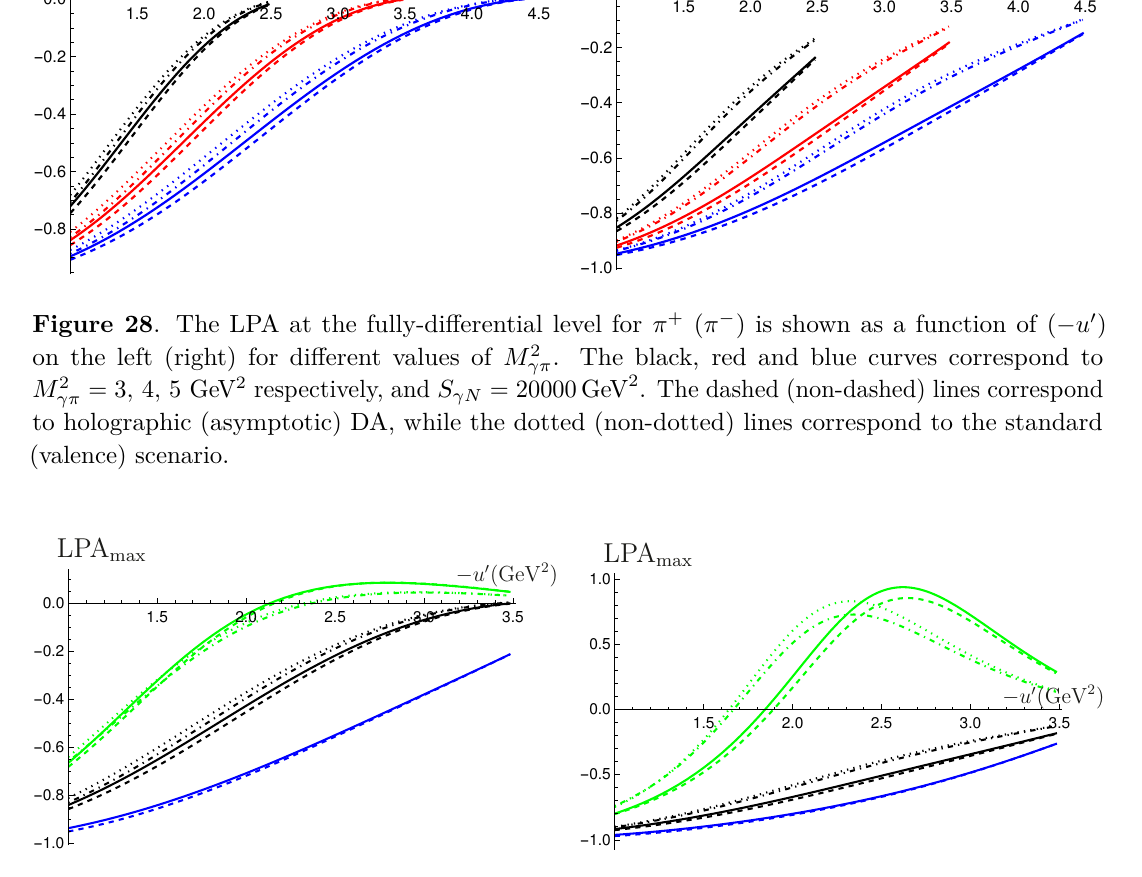
Figure 29 . The LPA at the fully-differential level for π + ( π − ) is shown as a function of ( − u 0 ) on the left (right), using M 2 = 4 GeV 2 and S = 20000 GeV 2 . The black curves correspond to γN γπ the total contribution, i.e. vector and axial GPD contributions combined. As before, the dashed (non-dashed) lines correspond to holographic (asymptotic) DA, while the dotted (non-dotted) lines correspond to the standard (valence) scenario. Note that the vector contributions consist of only two curves in each case, since they are insensitive to either valence or standard scenarios. The effect of using the valence or standard scenario is significant, while the difference between using asymptotic and holographic DA is